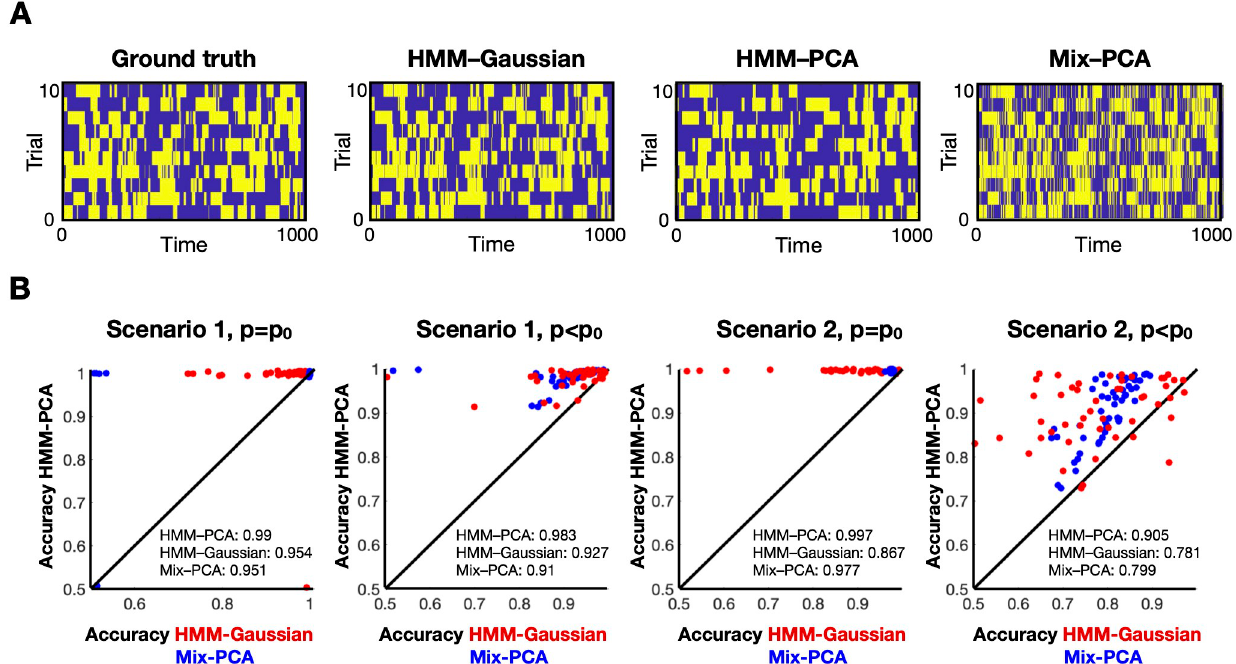
Fig 3. PCA introduces an estimation bias on the HMM or mixture model. A . The HMM inference is scale-invariant, but not PCA-rotation-invariant. State time courses produced by the HMM inference for one HCP subject on the original parcellation space (top), after applying a random scaling of the data (middle), and after PCA rotation with no loss of variance (bottom). Each colour represents a different state, so that the coloured areas indicate the probability of activation for the states across the session. The similarity between the different runs, expressed as Pearson’s correlation coefficients, are expressed on the right. B . The extent of this bias (PCA distortion) is logarithmically related to how concentrated is the variance on the first PCs (PCA concentration); that is, the more correlated are the regions on the original data, the stronger will be the bias introduced by PCA. C . Random manipulations of the data eigenvalues are correctly reflected as changes in the HMM-PCA estimations; HMM-Gaussian is not able to capture the